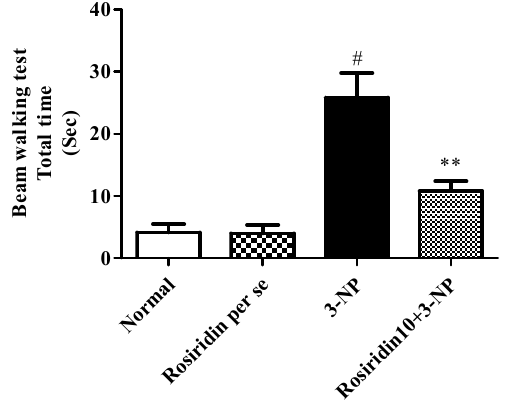
Figure 2. Effect of rosiridin on the narrow beam walk assessment. Values are expressed as the mean ± SEM (n = 6). Values are statistically significant at p < 0.05 (one-way ANOVA followed by Dunnett’s test). Express the data ( # p < 0.05) saline vs. negative control group; (** p < 0.01) negative control group vs. treatment group.